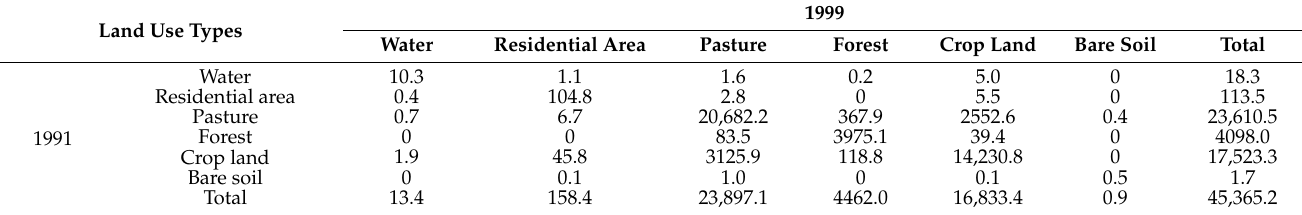
Table 3. LUCC transfer matrix of the JRB from 1991 to 1999 (area:km 2 ).